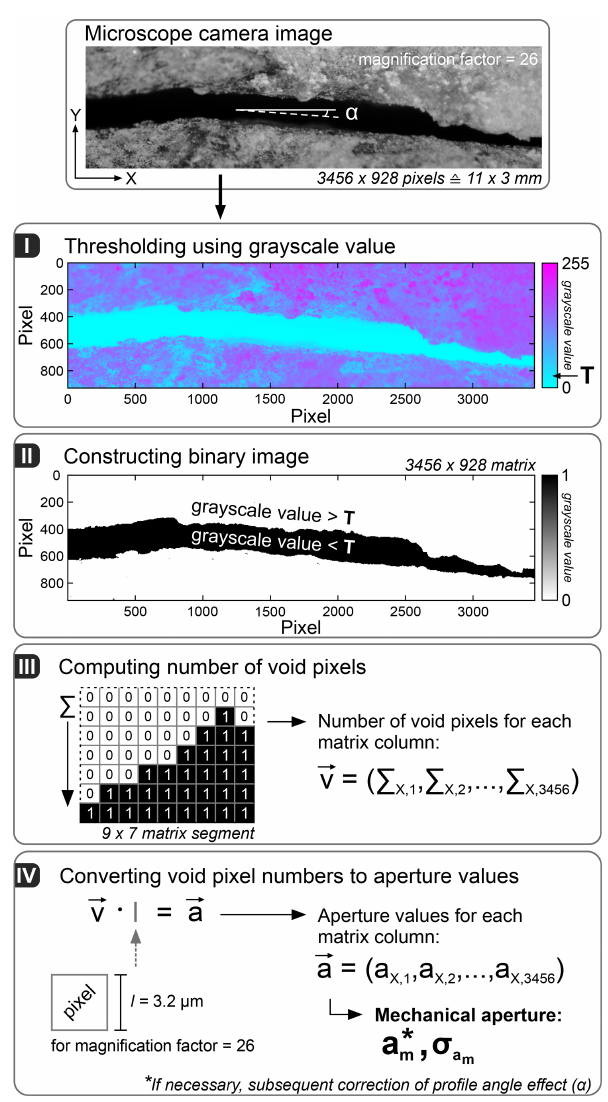
Figure 2. Workflow of the automatic approach for determining the mechanical fracture aperture based on microscope camera images of fracture trace